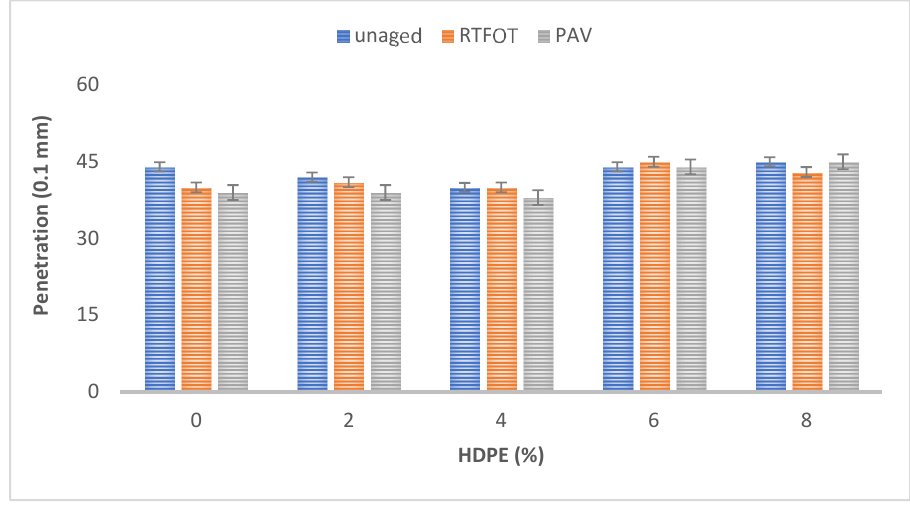
Figure 7. Penetration results for HDPE-modified bitumen after the RTFOT and PAV tests.